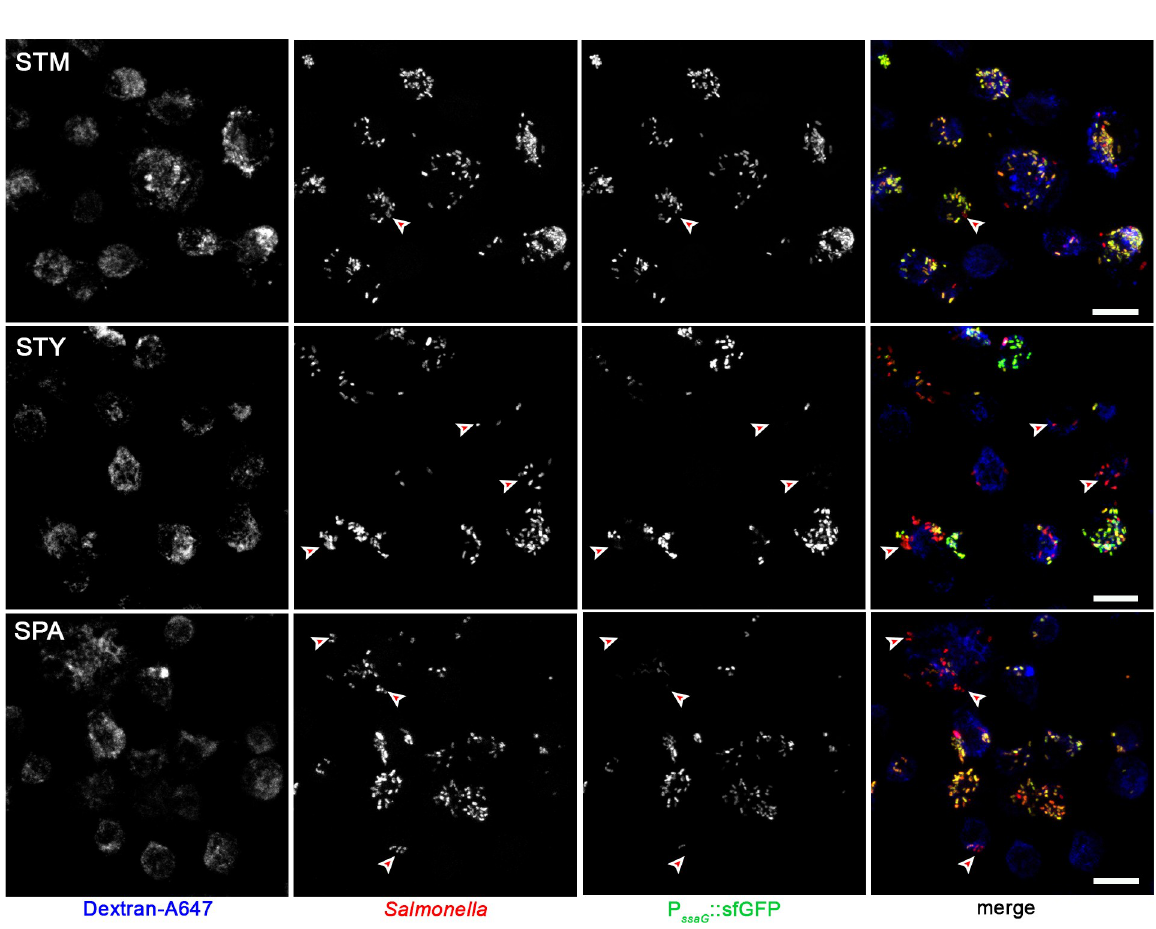
::sfGFP-negative ssaG